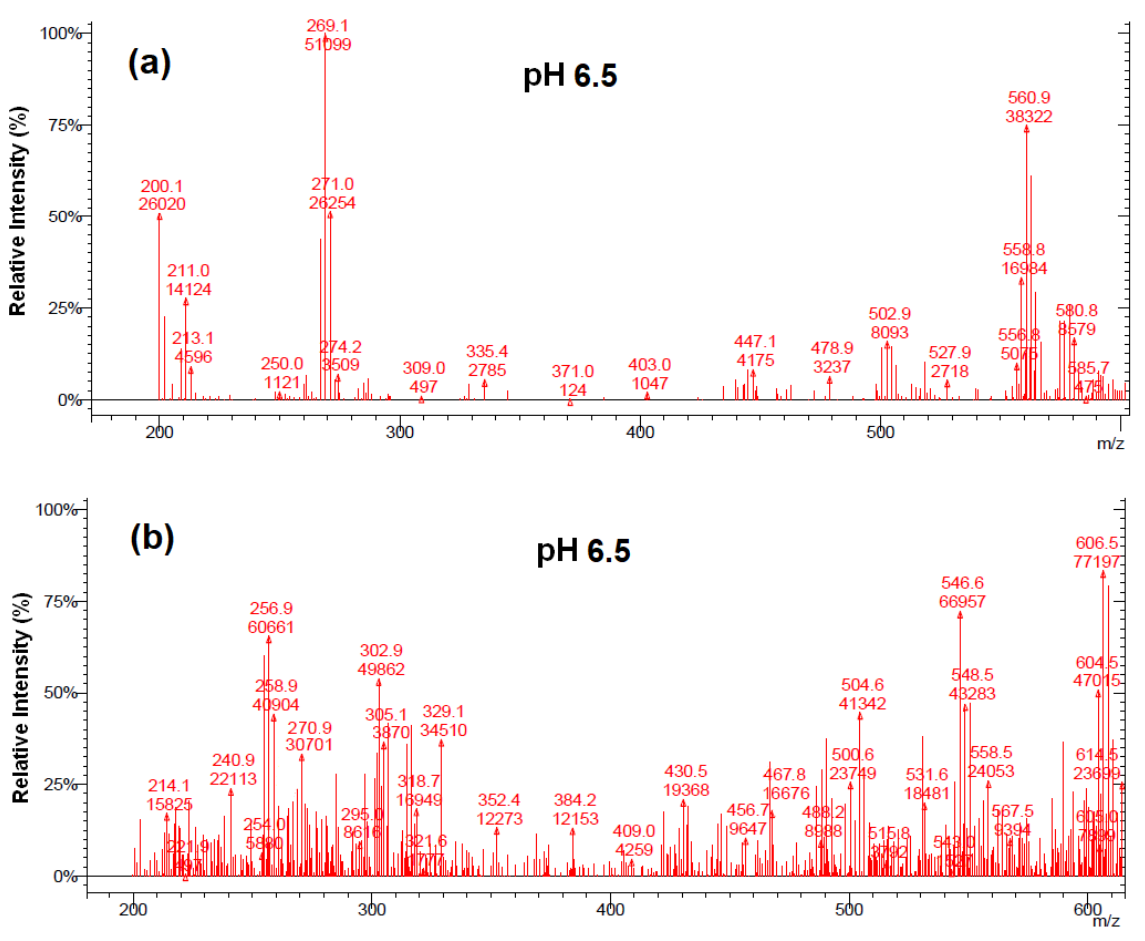
Fig. S5. (a) Negative-ion ESI–MS spectrum for the complexes formed in the FeCl /PicHA system at ligand-to-metal molar ratio 4:1, pH 6.5, C 3 L -1